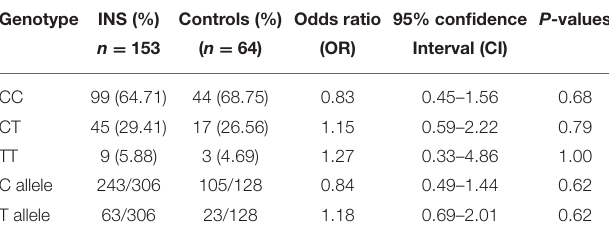
TABLE 2 | Interlukin-4 gene polymorphism in Kuwaiti children with INS and the controls.